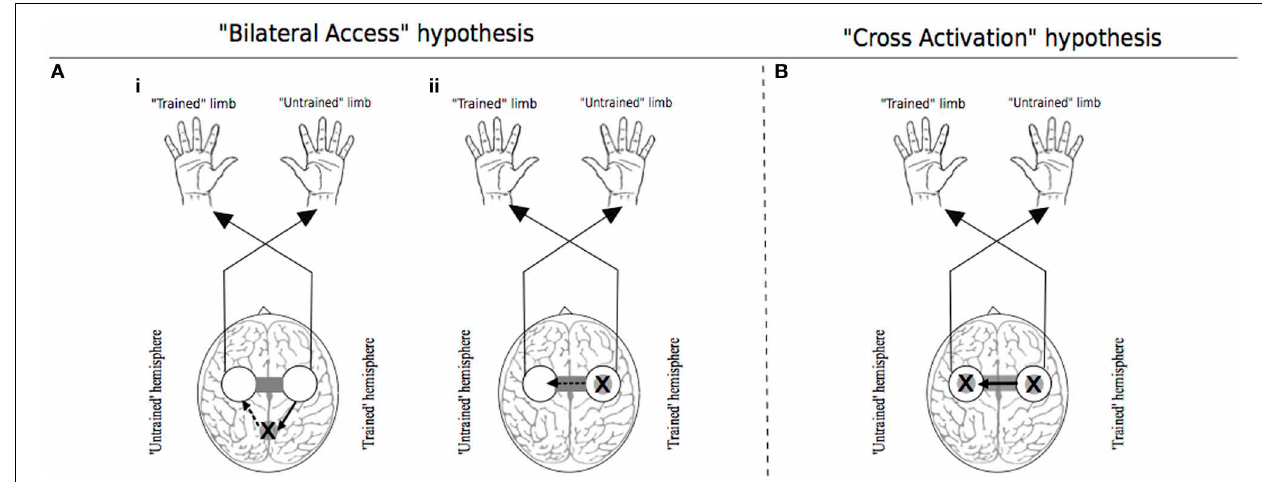
FIGURE 1 | Traditional theoretical models of cross education. In each instance the “X” represents the putative locus of training related adaptations. White circles indicate lateralized motor networks in their entirety. In Panel (A) , solid arrows represent processes that occur during unilateral training. Dashed arrows represent processes that are specific to the subsequent transfer phase during which movements are generated by the untrained limb. (Ai) illustrates the hypothesis that engrams elaborated during unilateral motor training are established in brain centers that are